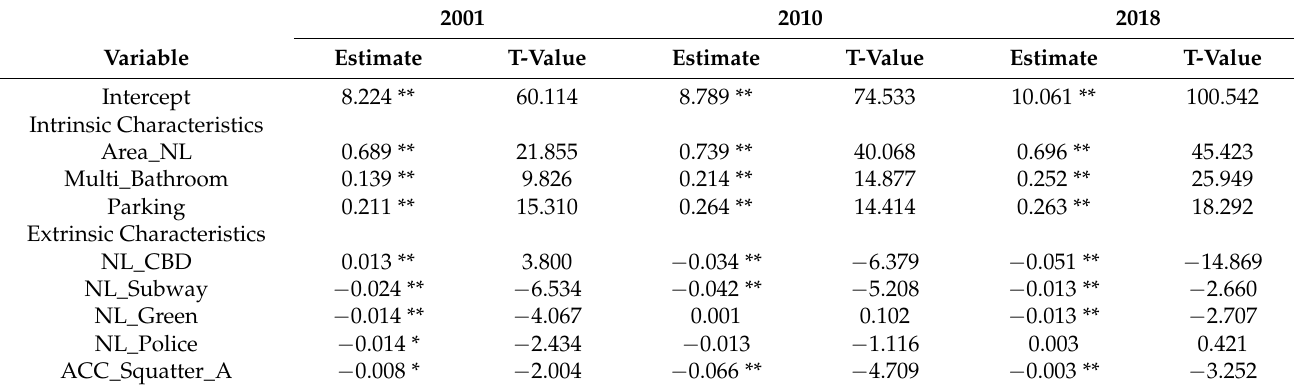
Table 6. Coefficient estimates of the global Model 2.